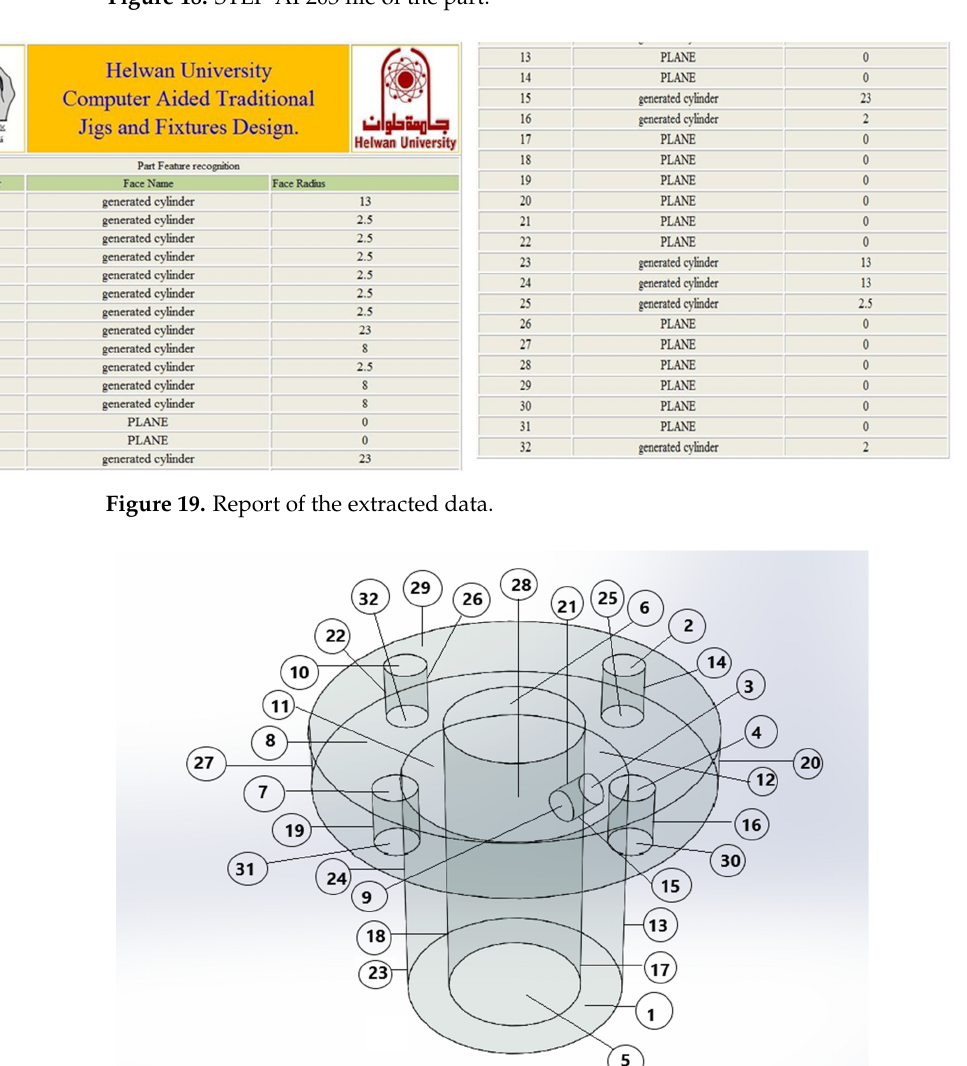
Figure 18. STEP-AP203 file of the part.